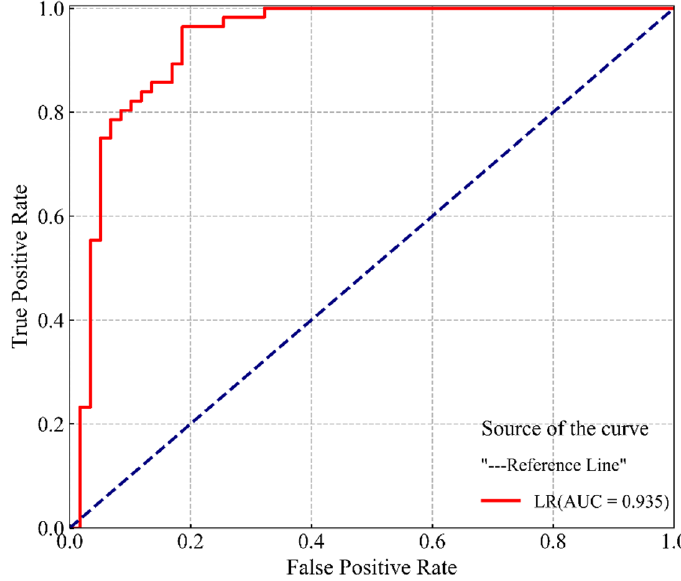
Figure 11. Comparison of cross-validation results of 10 candidate models. ( a ) Validation metrics: AUC and Accuracy, ( b ) Validation metrics: TS and Sensitivity.